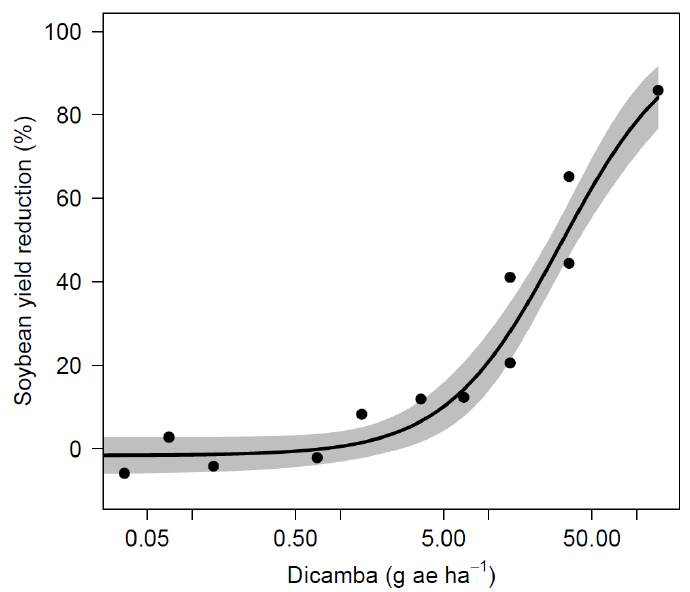
Figure 2. Soybean yield as affected by dicamba dosage.